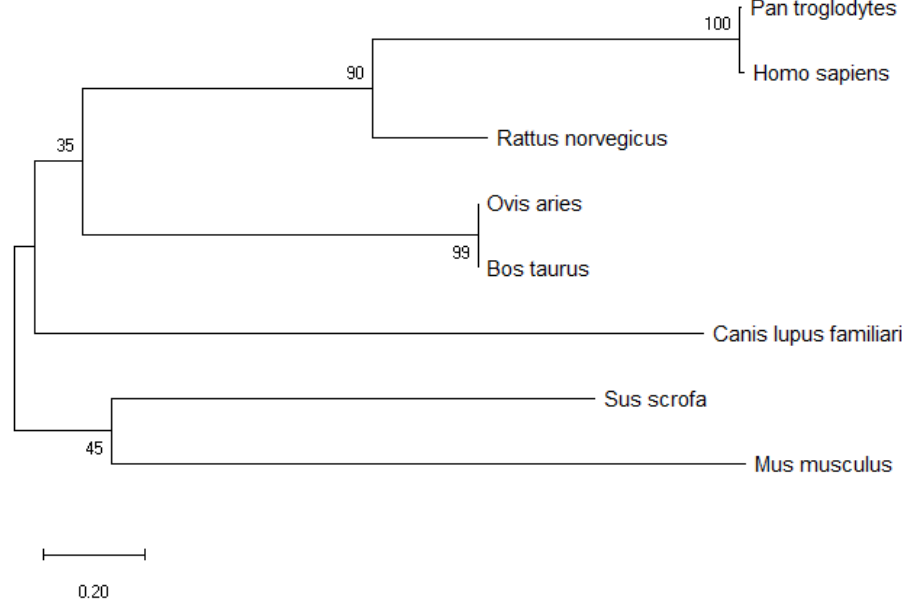
Figure 4. BMP7 promoter sequence (−758 to −545 bp) phylogenetic tree of eight species.